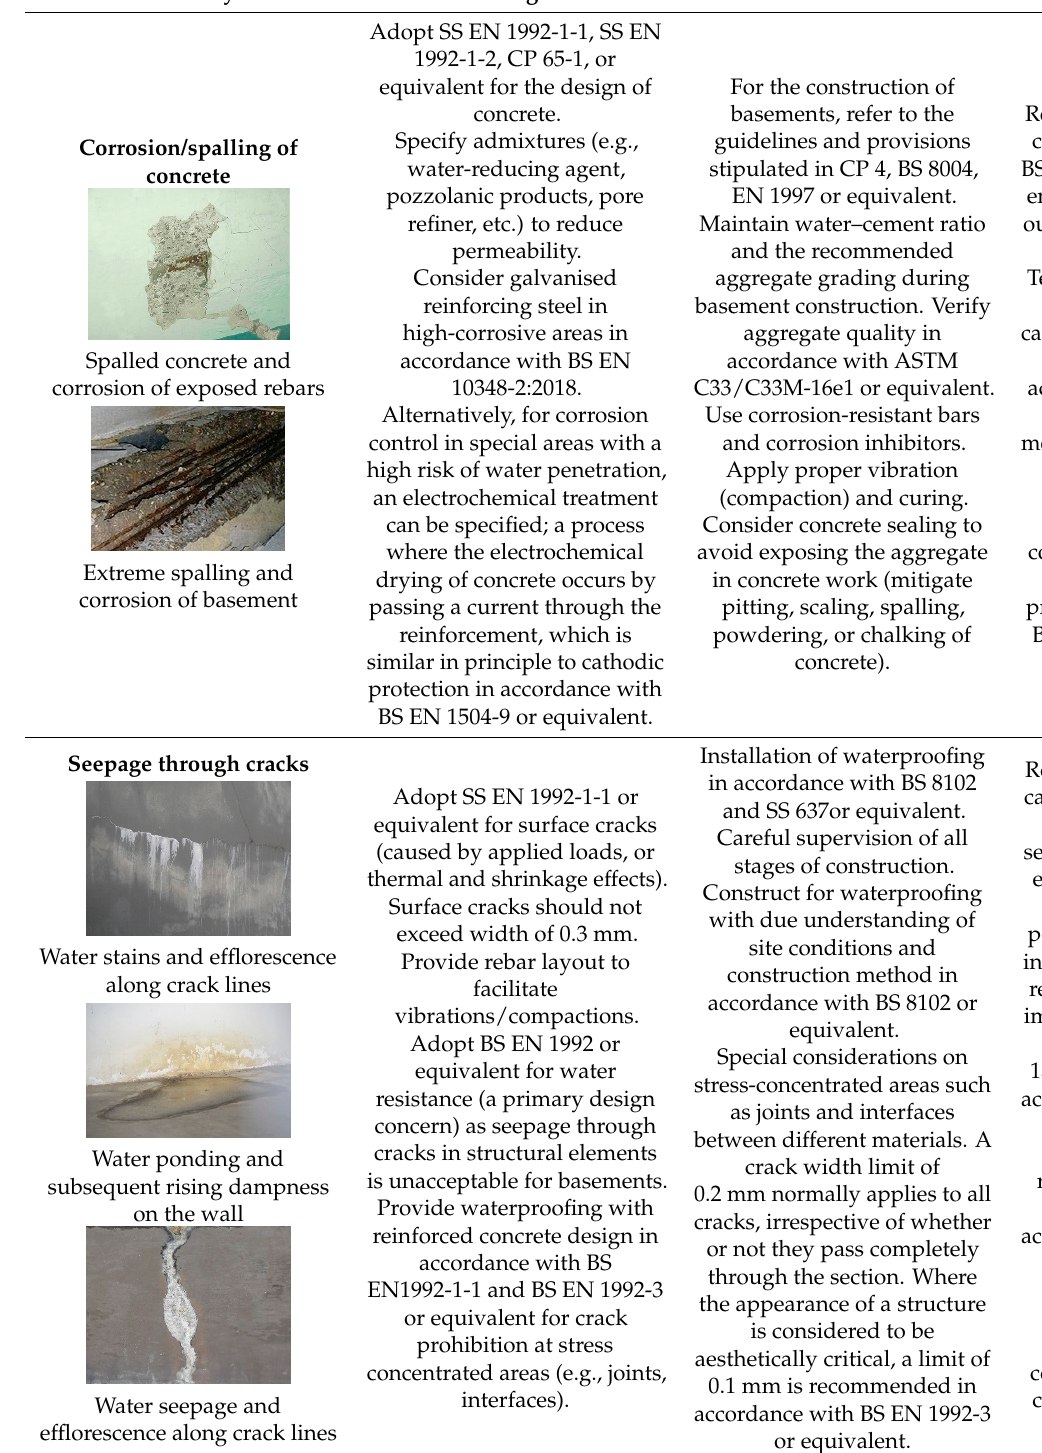
Table 2. Basements—Structural components e.g., floors, slabs, walls and other load-bearing and non-loading components. Anomaly